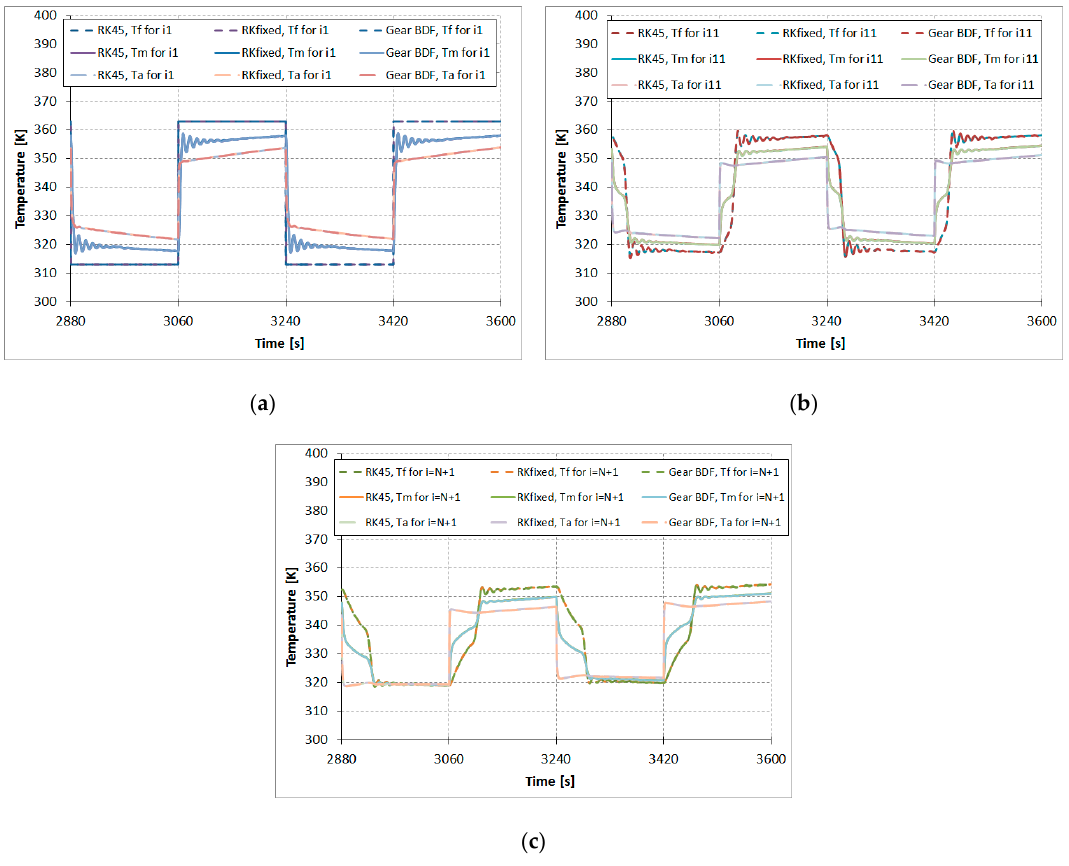
Figure 5. Results comparison of the Runge–Kutta fixed step size fourth-order (RKfixed), the Runge– Figure Kutta–Fehlberg 4.5th-order method with a variable step size (RK45), and the Gear Backward